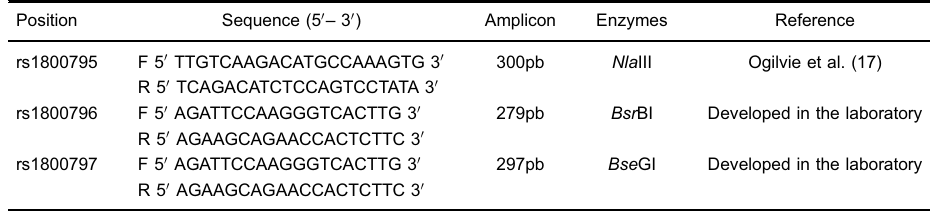
Table 1. Oligonucleotides used to amplify the fragments in question and their restriction enzymes.